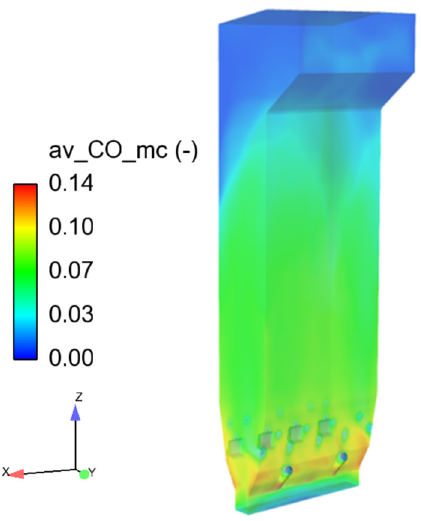
Figure 9. Three-dimensional contour of CO concentration in Case 1.